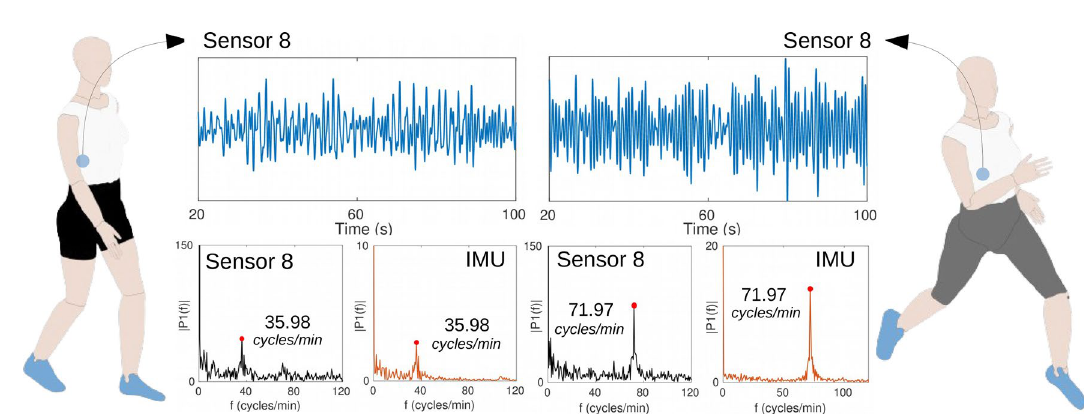
Figure 8. Results of walking and running tests of the volunteer 1 for cadence estimation: temporal response and FFT of the IMU data (yaw) and the response of sensor